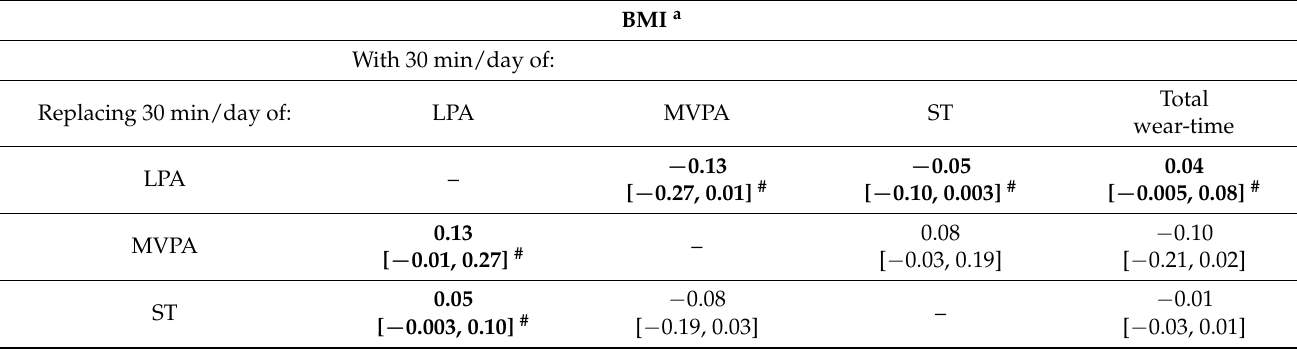
Table 2. Cross-sectional replacement effects ( β [95% CI]) at the follow-up of substituting 30 min of non-school time LPA, MVPA, and ST on BMI, WHR, and BF% in boys ( n = 65). BMI a With 30 min/day